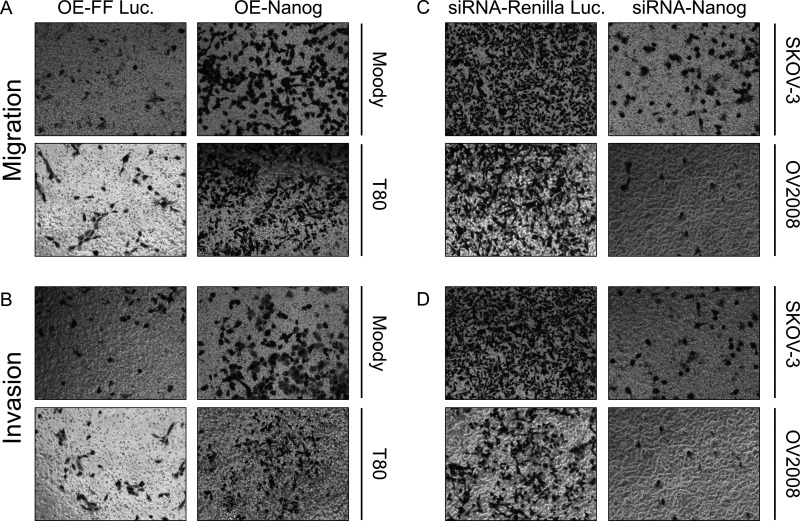
Modulating NANOG expression affected in vitro migration and invasionOverexpression of NANOG increased in vitro cell migration (A) and invasion (B) in the Moody and T80 cells. RNAi-mediated silencing of NANOG decreased in vitro cell migration (C) and invasion (D) in the SKOV-3 and OV2008 cells respectively. The migrated and invasive cells were photographed using a microscope.